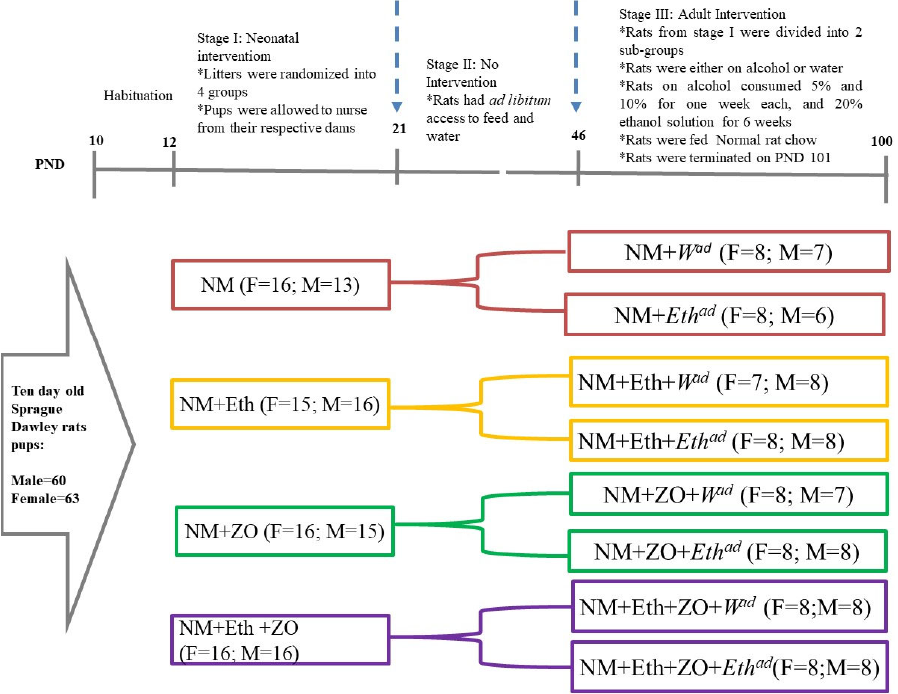
Figure 1. Study experimental design: control (NM + W ad )—neonatally gavaged with nutritive milk (NM) and drank plain drinking water ( W ad ) at stage III; late single hit (NM + Eth ad )—neonatally ga ‐ vaged with NM and drank ethanol ( Eth ad ) solution at stage III; early single hit (NM + Eth + W ad )— neonatally gavaged with ethanol in nutritive milk and drank plain drinking water ( W ad ) at stage III; double hit (NM + Eth + Eth ad )—neonatally gavaged with Eth in nutritive milk and drank Eth ad at stage III; zingerone alone (NM + ZO + W ad )—neonatally gavaged with ZO in nutritive and drank plain drinking water ( W ad ) at stage III; early single hit with zingerone (NM + Eth + ZO + W ad )— neonatally gavaged with NM, Eth, ZO and drank plain drinking water ( W ad ) at stage III; late single hit with zingerone (NM + ZO + Eth ad )—neonatally gavaged with NM and ZO and drank Eth ad at stage III; double hit with zingerone (NM + Eth + ZO + Eth ad )—neonatally gavaged with NM, Eth and ZO and drank Eth ad at stage III; F—female; M—male; NM—nutritive milk; Eth—ethanol; ZO— zingerone; W—water; n = 6–8 per treatment